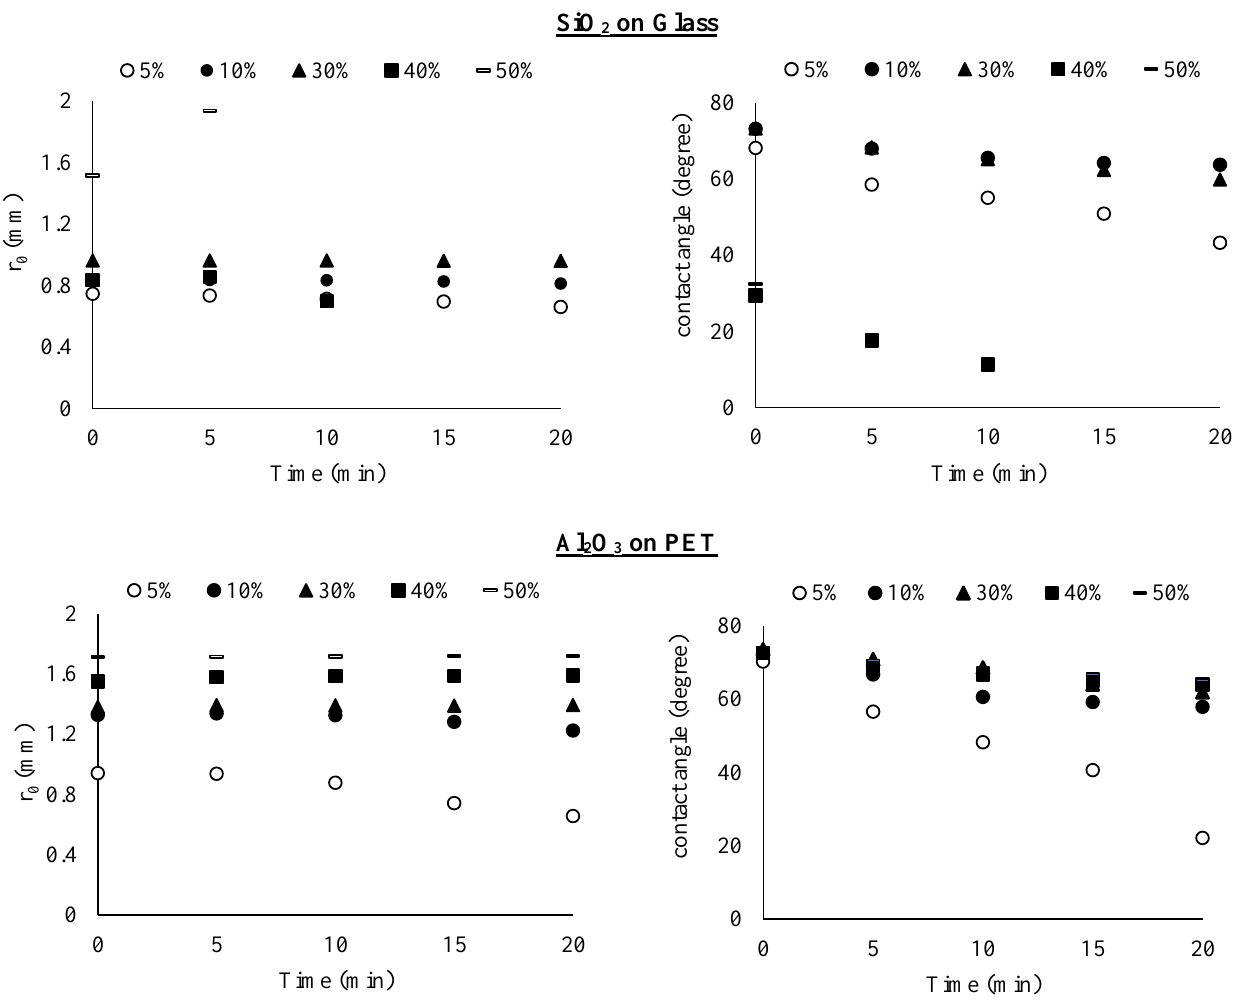
Figure 5—Basal radius r and contact angle α shown for two systems as functions of time. The measurements 0 were taken using a contact angle goniometer. Note that at the smallest concentrations there is a continuous drop in r . The measurements were problematic in case of 50 wt% particles. 0